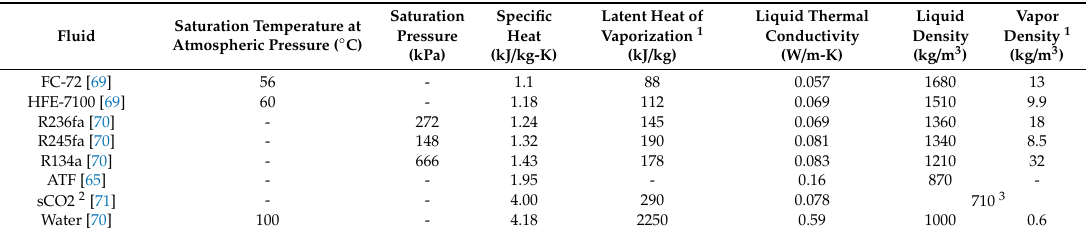
Table 2. Comparison of common working fluids for embedded two-phase coolers. All properties at 25 ◦ C unless otherwise